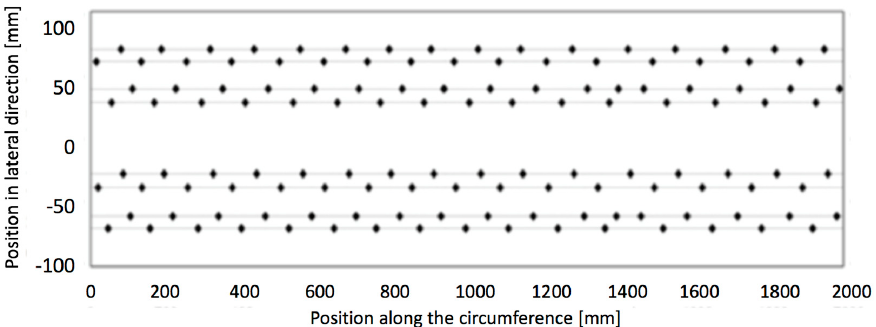
Figure 14. A typical stud pattern (8 stud lines with 16 stud on each line, 128 studs in total) (modified from Johnsson and Nyka ̈ nen, 2013 [133], Figure 3).